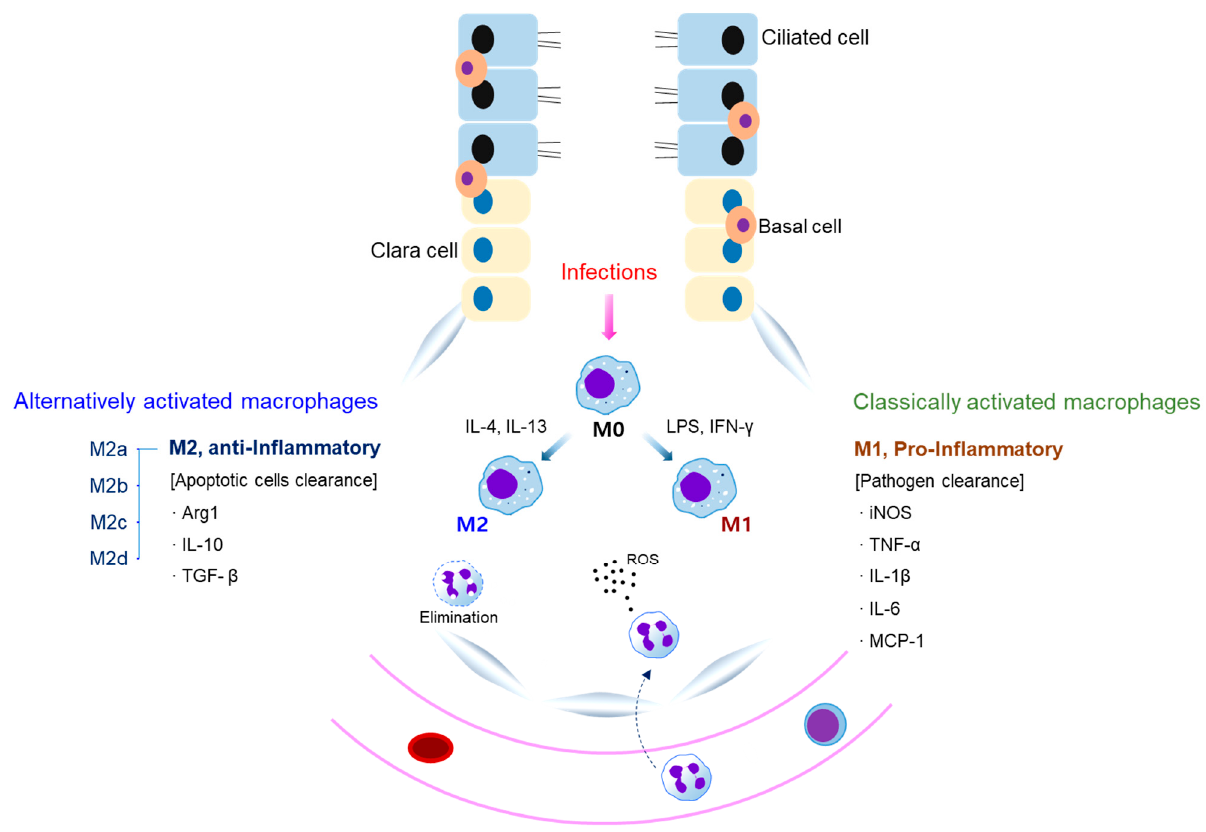
Figure 2. The role of macrophages in ALI/ARDS. Bacterial infection induces the development of ALI and ARDS. Under these conditions, AMs can be classified as M1 and M2 macrophages. Th1 cytokines, such as IFN- γ , and lipopolysaccharide (LPS), induce M1 phenotype macrophages, which produce iNOS, TNF- α , IL-6, and MCP-1, which are responsible for the pro-inflammatory, chemotaxis, radical formation, matrix degradation, and antimicrobial activities during the pathogenesis of ALI/ARDS. Th2 cytokines, such as IL-4 and IL-13, induce M2 phenotype macrophages (divided into M2a, M2b, M2c, and M2d), and these cells produce anti-inflammatory molecules, such as IL-10 and TGF- β , in